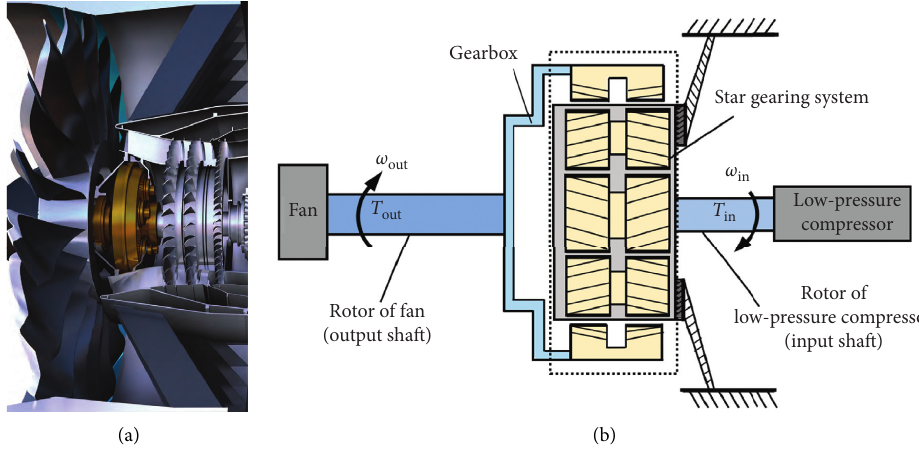
Figure 1: Structure of GTF gearbox: (a) physical model and (b) schematic diagram.